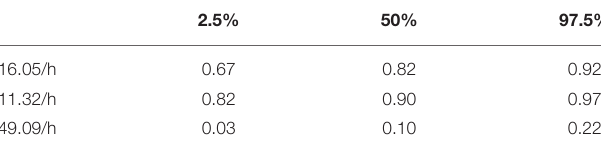
TABLE 5 | 95% confidence intervals for PTT arousal index sensitivity at the three thresholds of sensitivity (training data).